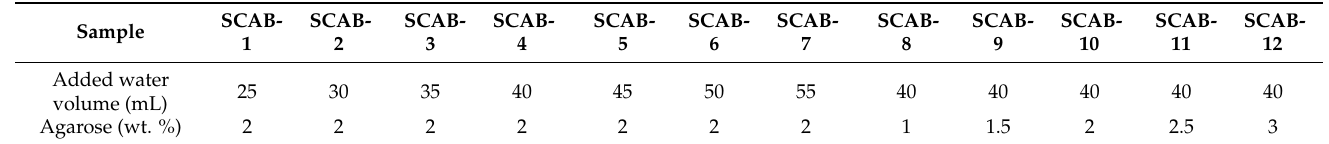
Table 3. Volumes of deionized water added to prepare ACG and concentrations of agarose solutions used in each sample are shown in Table